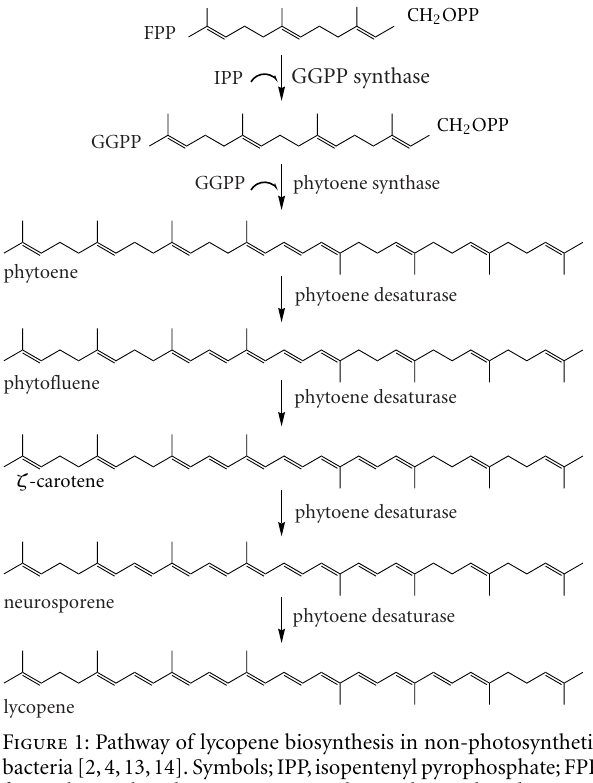
Figure 1: Pathway of lycopene biosynthesis in non-photosynthetic bacteria[2,4,13,14].Symbols;IPP,isopentenylpyrophosphate;FPP, farnesyl pyrophosphate; GGPP, geranylgeranyl